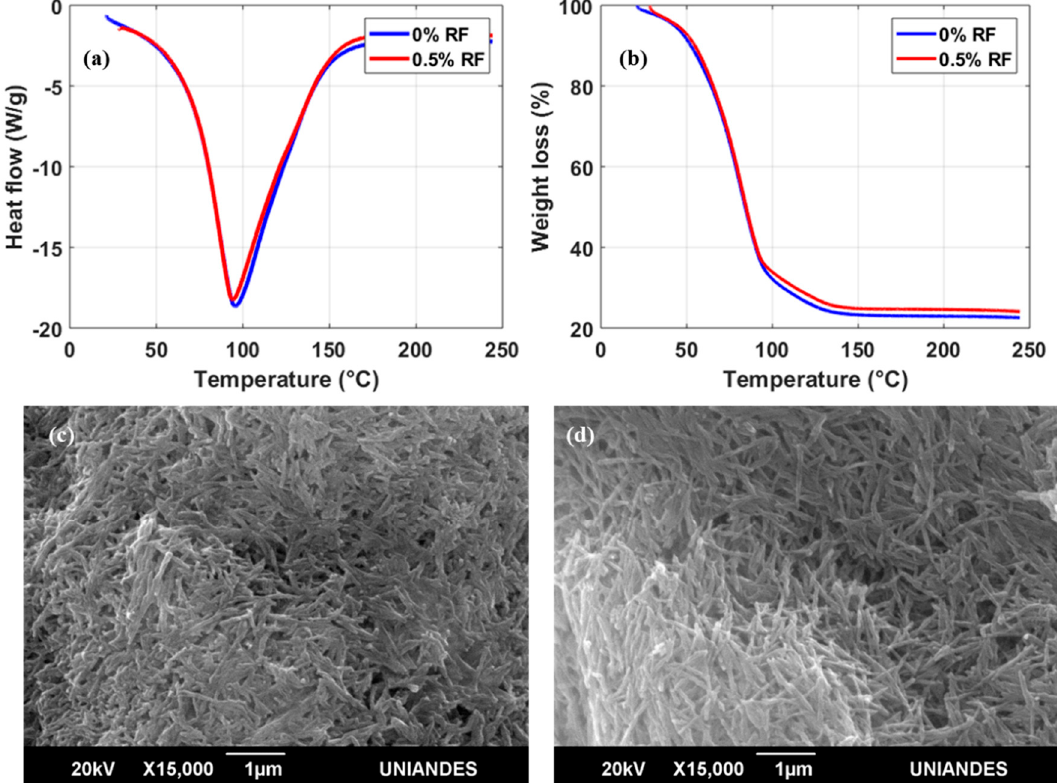
Figure 3. ( a ) Differential scanning calorimetry (DSC) and ( b ) thermogravimetric analysis (TGA) thermograms between RT and 250 °C after irradiation of the samples. Scanning electron microscopy ( SEM) images of the bioinks at 15,000× magnification with a 20 kV accelerating voltage: ( c ) 0% ( w / v ) RF and ( d ) 0.5% ( w / v ) RF.